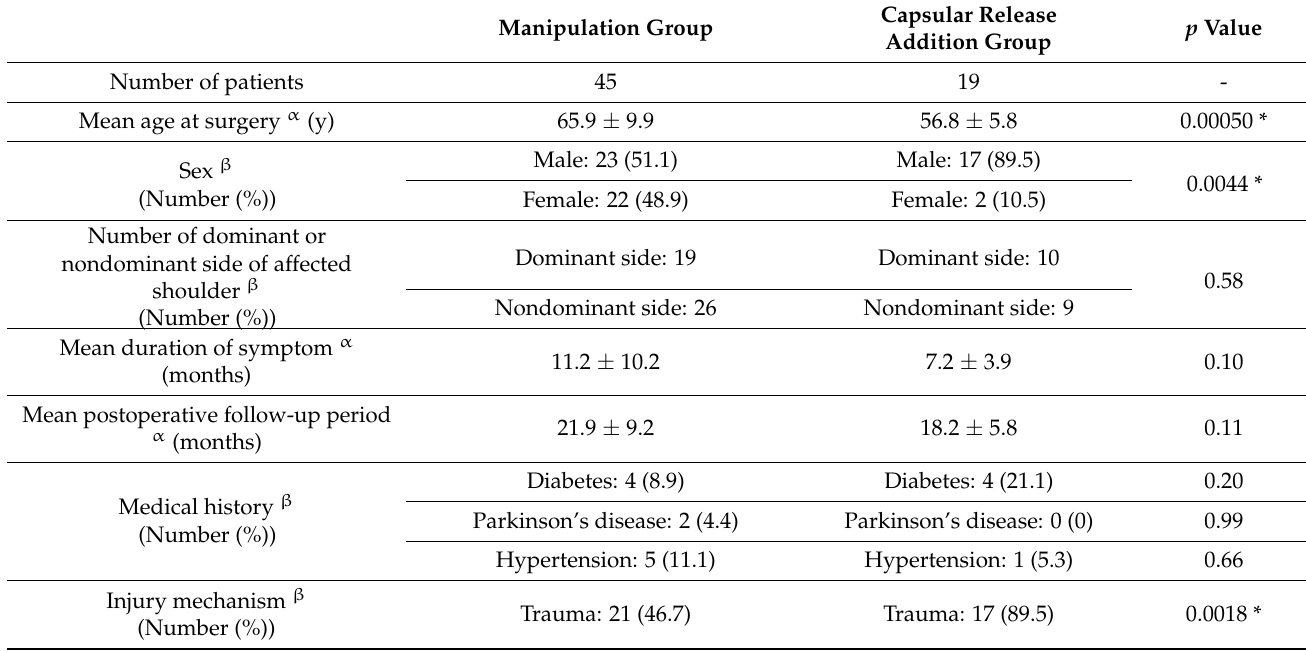
Table 1. Comparison of patient demographics between two groups. Manipulation